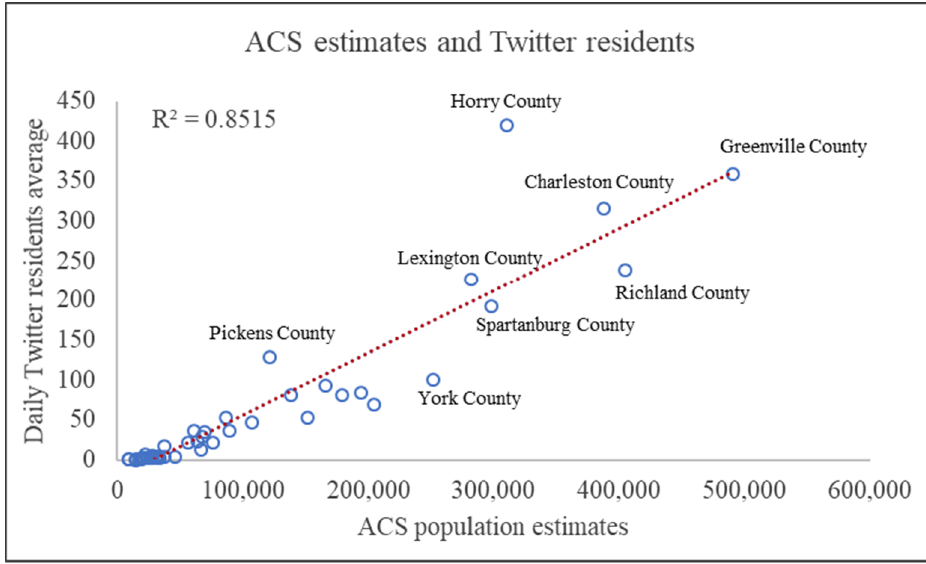
Figure 2. Scatter plot of 5-year ACS county population estimates and the daily average of total active Twitter residents per county (46 counties in